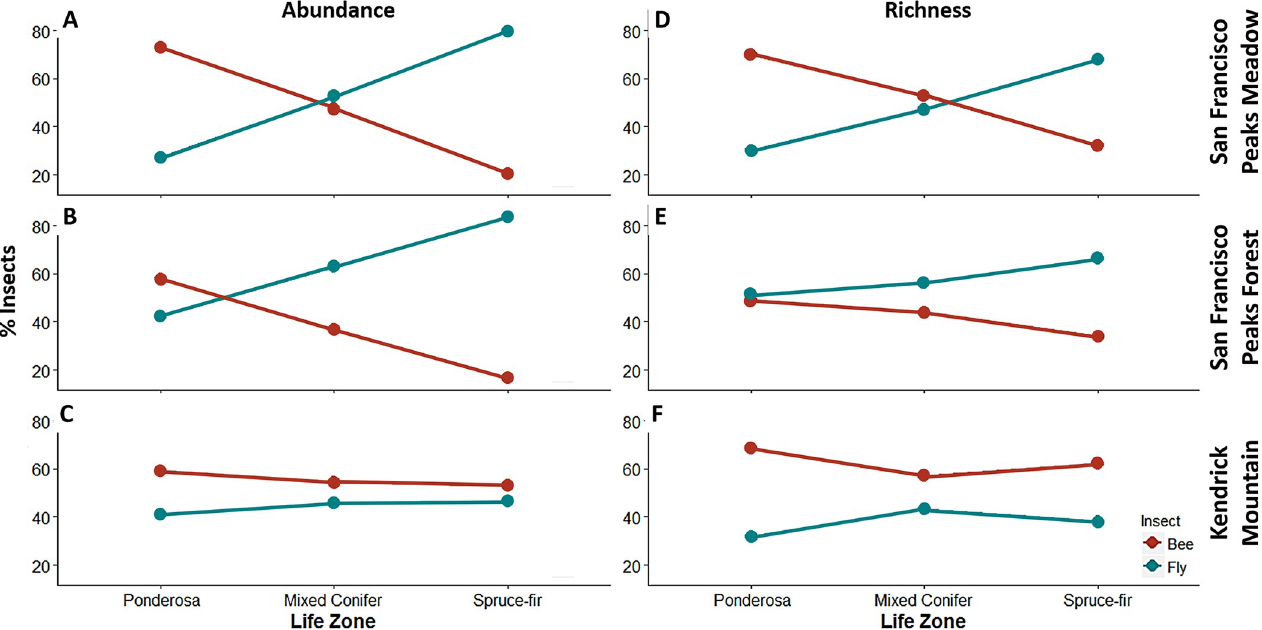
Fig 1. Cup sampling shows changes in both relative abundance and species richness for bees and flies along elevational gradients on two mountains. Changes in abundance of San Francisco Peaks meadow (A) and forest (B) as well as Kendrick Mountain, a no canopy cover mountain (C). Changes in richness of San Francisco Peaks meadow (D) and forest (E) as well as Kendrick Mountain, a no canopy cover mountain (F). Bee species are depicted in as the red line and fly species are depicted as the blue lines. Mean and Standard Errors displayed.